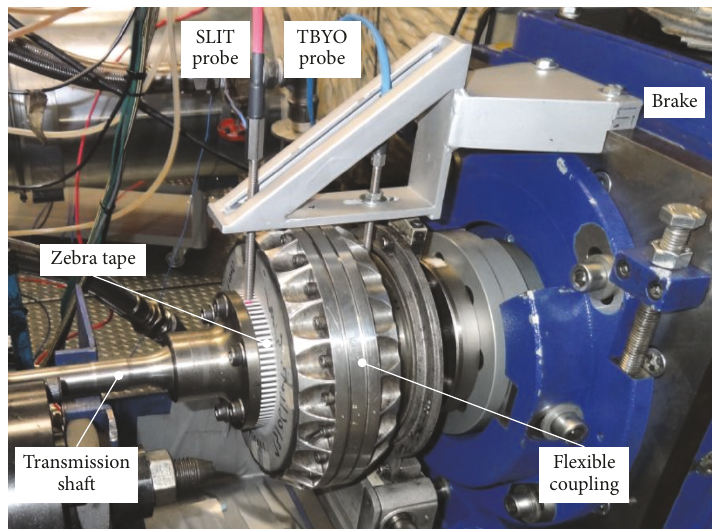
Figure 4: Test rig and optical sensor